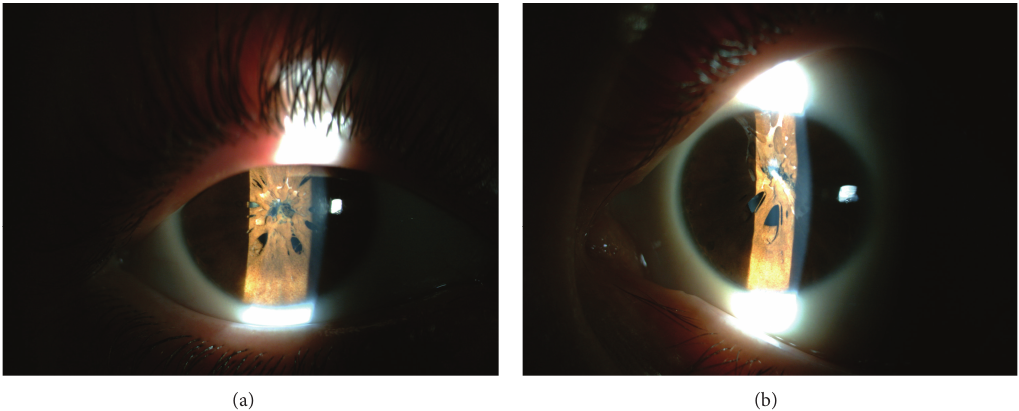
Figure 2: After administration of cyclopentolate eye drops, some parts of lens and fundus were observable and appearing within normal limits in the right eye (a) and in the left eye (b).